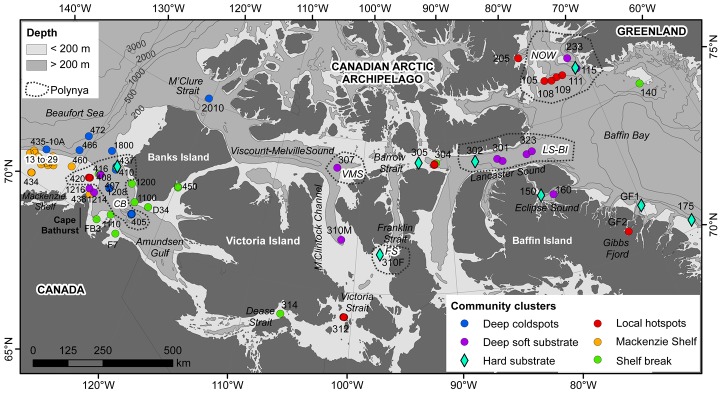
Locations of the six megabenthic community clusters.